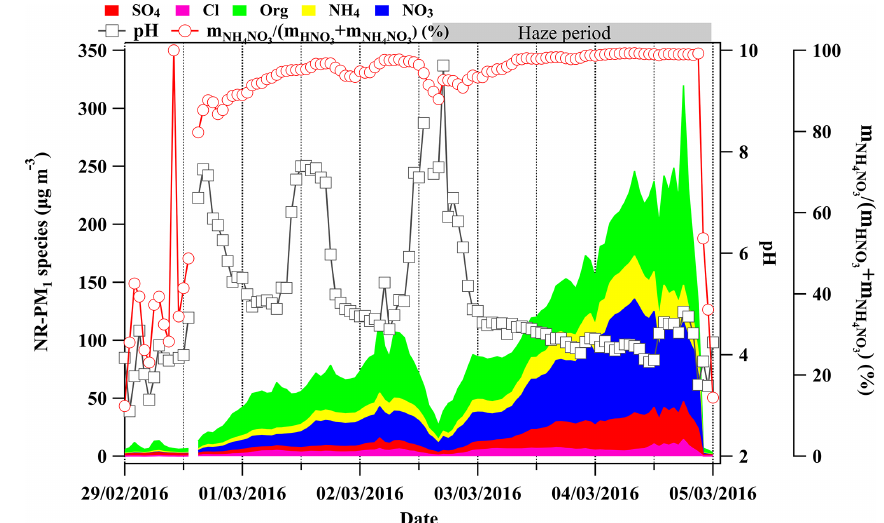
Figure 5. The time series of chemical composition measured by the HR-ToF-AMS (left y axis), calculated aerosol pH by ISORROPIA II (inner right y axis) and the molar ratio of particulate nitrate in the total nitrate (gas + particle phase) shown on the outer right y axis during 29 February to 5 March 2016.